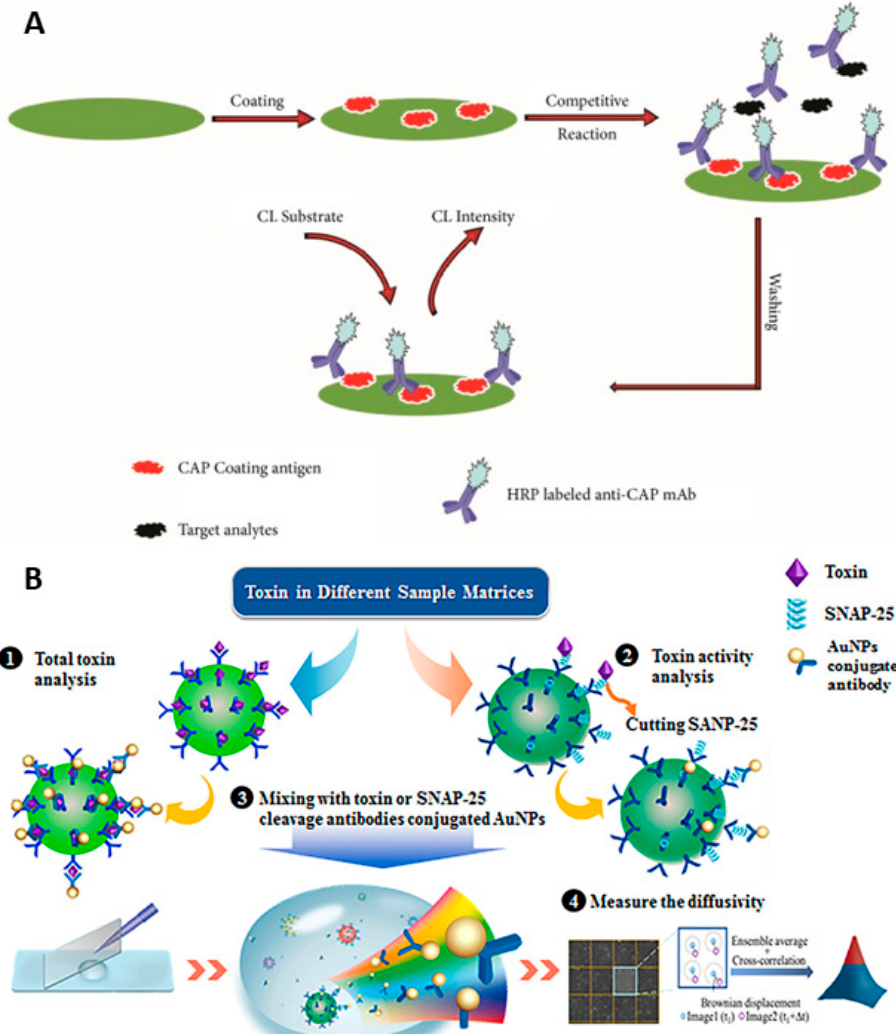
Figure 4 . Panel ( A ): Schematic of the CL-ELISA method. Reprinted with permission from Ref [92], copyright 2019. Panel ( B ): Conceptual scheme of the immune-sensing platform to perform the total toxin analysis and the toxin activity analysis in different complex matrices. Steps 1 and 2: Anti-BoNT/A or SNAP-25 antibodies were linked to AuNPs. (In the picture, SANP-25 stands for SNAP-25.) Step 3: While incubating the particle with the sample that can contain the toxin of interest, antibodies conjugated with AuNPs were added, allowing the formation of the “sandwich” immunocomplex. Step 4: Toxin concentration or activity was assessed by employing an imaging-based method using a microscope and a cross-correlation algorithm to estimate the level of Brownian motion. Reprinted from Ref. [96] with permission from ACS https://pubs.acs.org/doi/abs/10.1021/acssensors.9b00644 (accessed on 5 November 2021). Further permission related to the material excerpted should be directed to